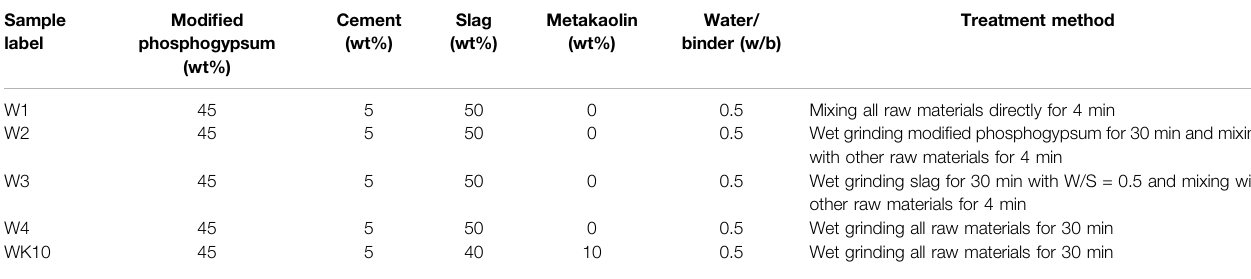
TABLE 2 | Mix proportions of specimens (wt%). Sample